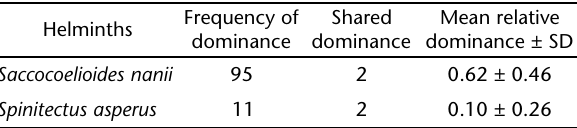
Table II. Dominance analyses of helminths of P. argenteus from the Upper São Francisco River, Minas Gerais. (SD) Standard deviation. Helminths